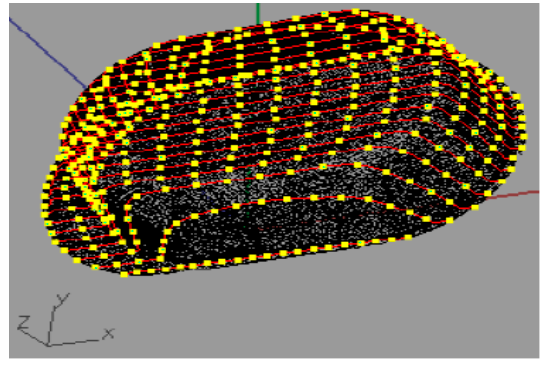
Figure 11. U-direction Spatial Path. Electronics 2019 , 8, x FOR PEER REVIEW